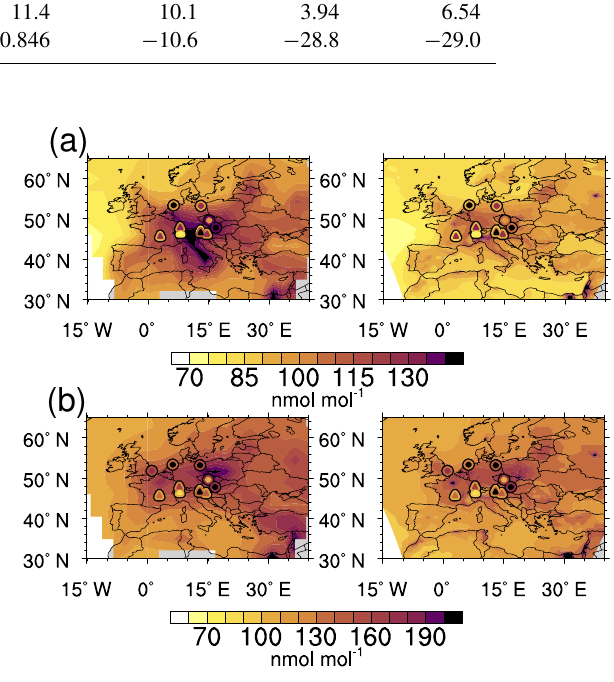
Figure 6. Monthly averaged nitrogen dioxide concentrations (µg(N)m − 3 ) at the lowest model layer in (a) June and (b) Decem- ber 2008 from EMAC (left) and CM50 (right). The inner parts of the coloured dots show the monthly mean values measured at the corresponding stations, while the outer parts depict the simulated value corrected for the station elevation. Triangles indicate stations higher than 800m, circles stations below that height.